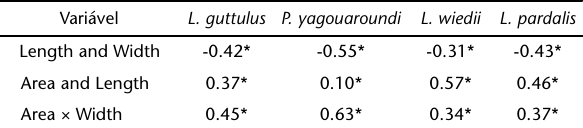
Table I. Pearsons’s correlation coefficient between the cuticular variables: width, length and area of the cuticular scales of the secondary guard hairs of small felids in the Brazilian Neotropical forest. Variável L. guttulus P. yagouaroundi L. wiedii L. pardalis Length and Width -0.42* -0.55* -0.31* -0.43* Area and Length 0.37* 0.10* 0.57* 0.46* Area × Width 0.45* 0.63* 0.34* 0.37*